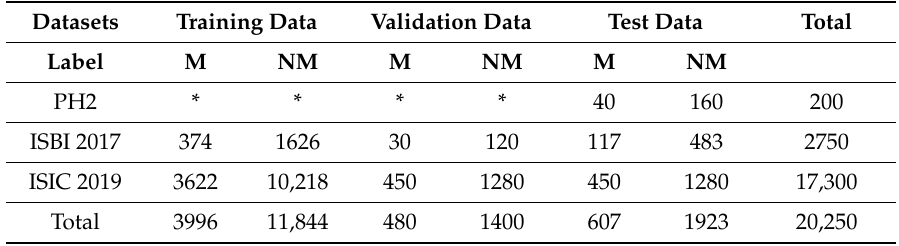
Table 5. Distribution of selected images from PH2, ISBI 2017 and ISIC 2019 datasets used in the proposed